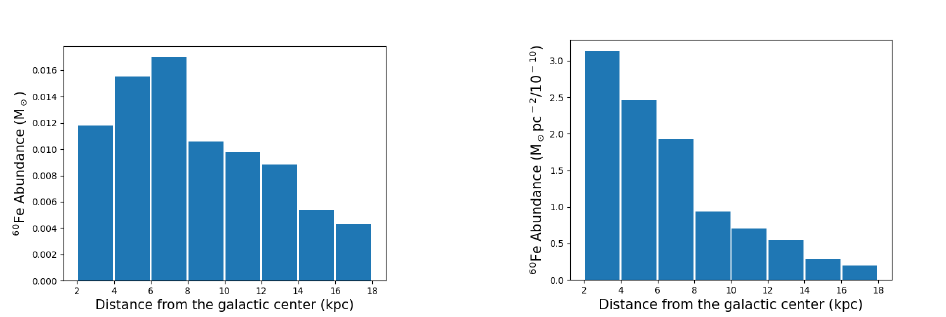
Figure 2. (Left) Absolute abundance of 60 Fe abundance, (Right) 60 Fe per unit area in the Galaxy for eight annular rings from 2-18